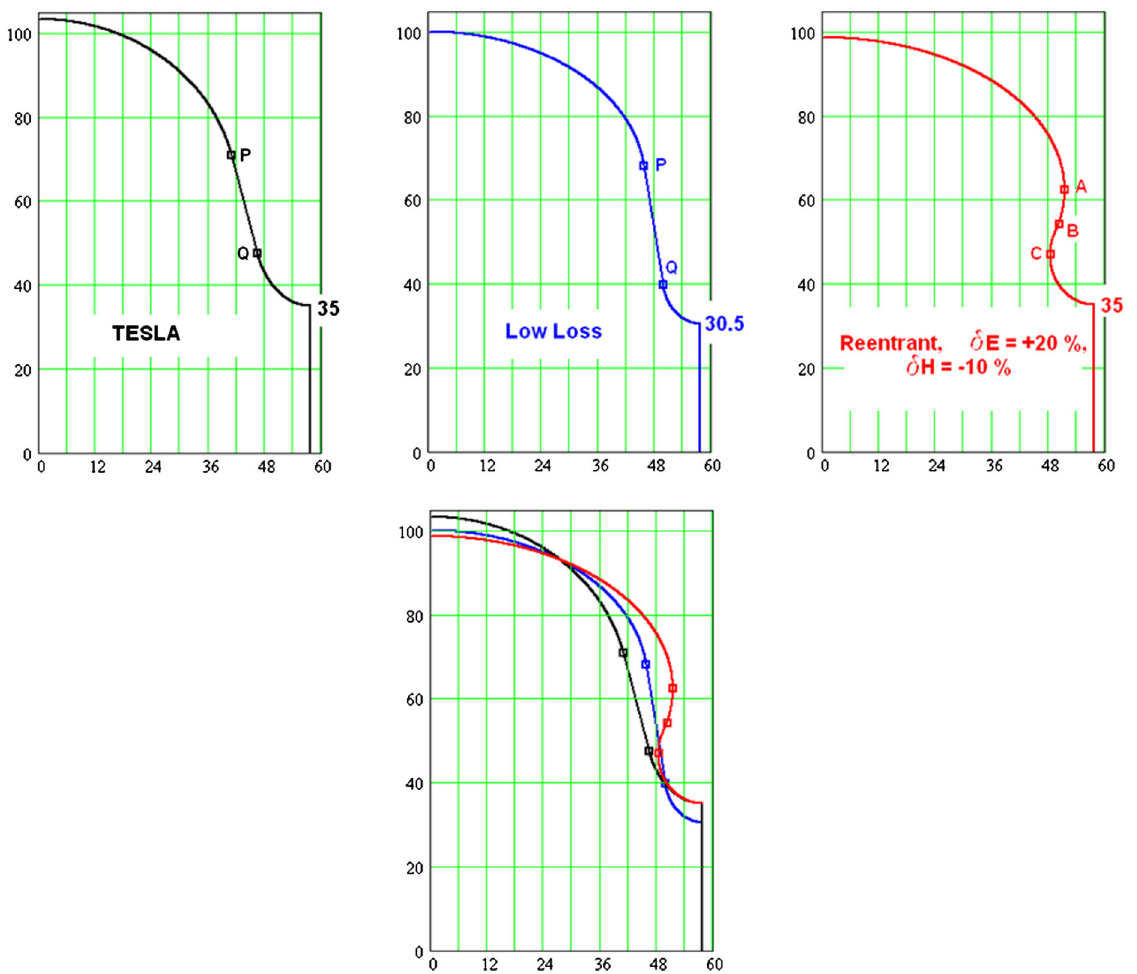
FIG. 2. Comparison of three known geometries of the elliptic half-cells. Dimensions are in